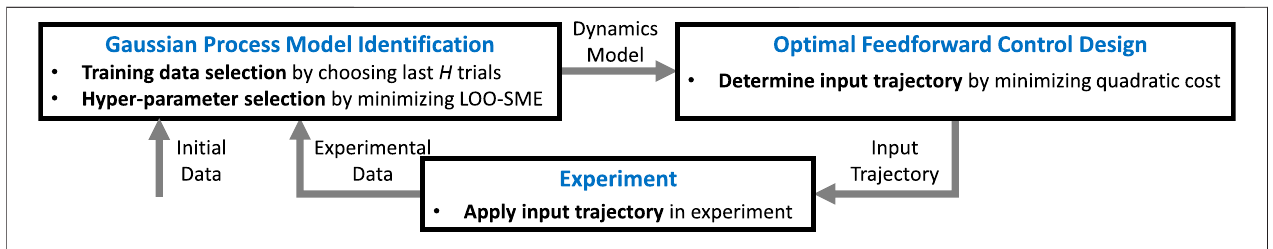
Frontiers in Robotics and AI |